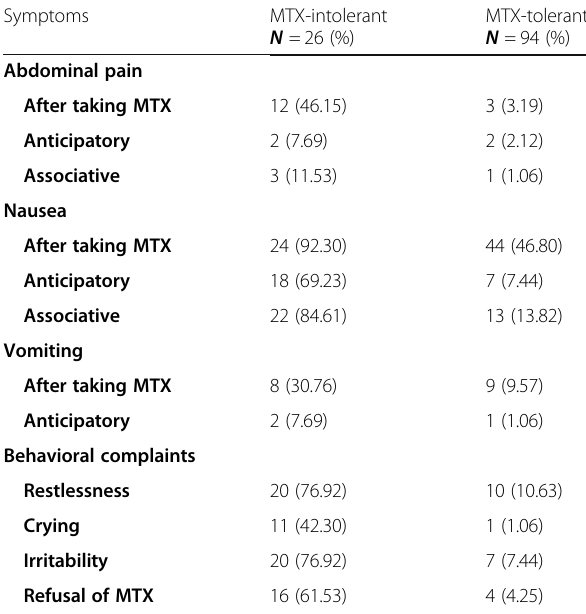
Table 2 Prevalence of MTX-related symptoms in MTX-tolerant and MTX-intolerant patients